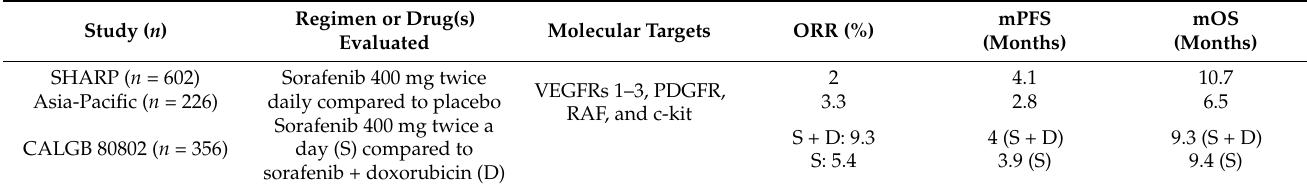
Table 1. Key phase III clinical trials of US FDA approved therapies in hepatocellular carcinoma. Study ( n